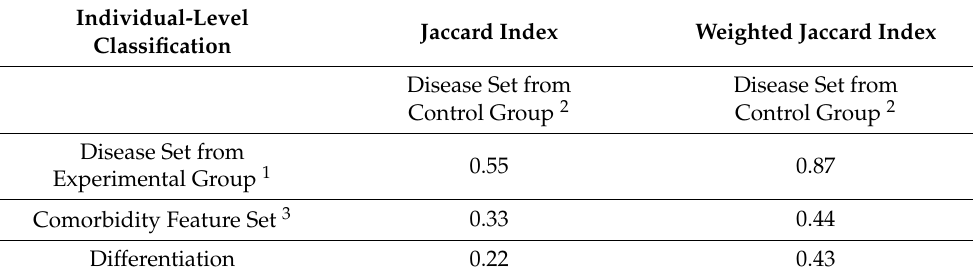
Table 3. Jaccard index and weighted Jaccard index similarities pairwise ALS_EG_FEA , ALS_CG_FEA , and ALS_SELECT_FEA (individual-level